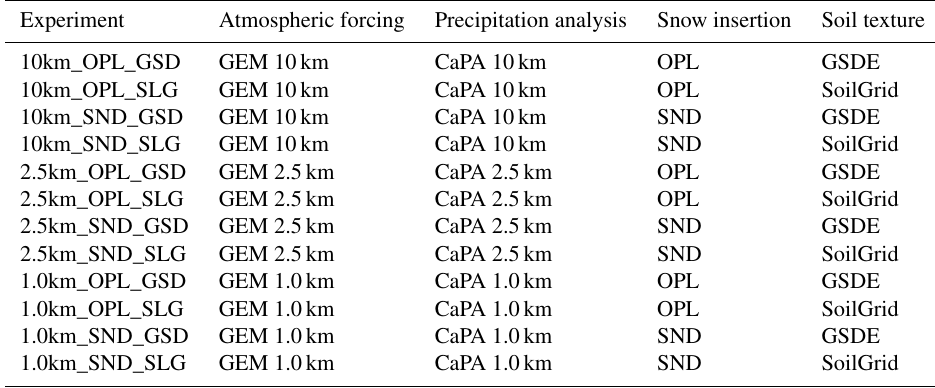
Table 4. Main characteristics of hydrological simulations carried out with GEM-Hydro. Experiment Atmospheric forcing Precipitation analysis Snow insertion Soil texture 10km_OPL_GSD GEM 10km CaPA 10km OPL GSDE 10km_OPL_SLG GEM 10km CaPA 10km OPL SoilGrid 10km_SND_GSD GEM 10km CaPA 10km SND GEM 10km CaPA 10km SND